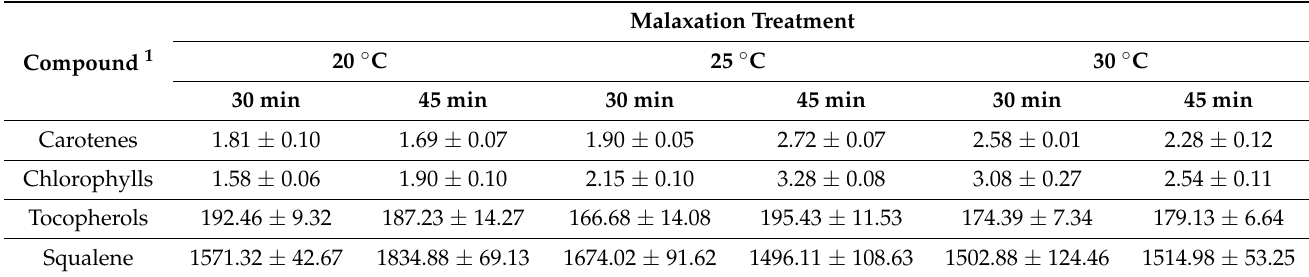
Table 4. Concentration of carotenes, chlorophylls, tocopherols, and squalene in all the olive oil samples